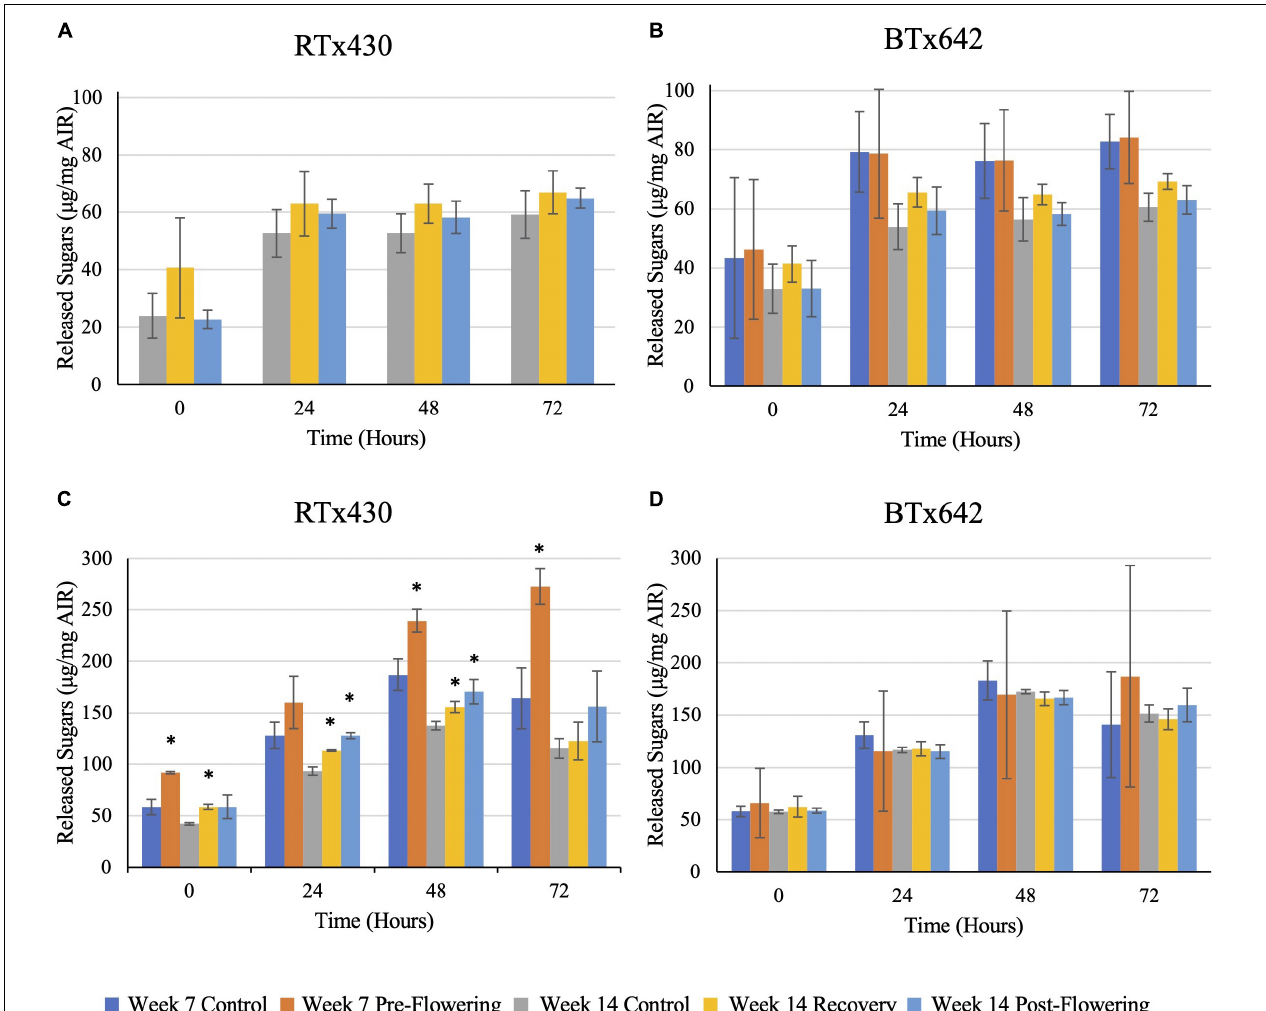
FIGURE 5 | Saccharification efficiency with a hot-water pre-treatment of leaf samples. Samples were pre-treated using hot water before a 72-h digestion with CTec3. Reducing sugars were assayed via 3,5-dinitrosalicylic acid. Panels (A,B) refer to de-starched samples, (C,D) refer to AIR with starch intact. The data represents mean ± SD of three biological replicates per genotype per condition with samples themselves consisting of leaves pooled from ten plants within the same planting block. Standard deviation error bars, with asterisks indicate p < 0.05 using Student’s t -test with the Benjamini–Hochberg